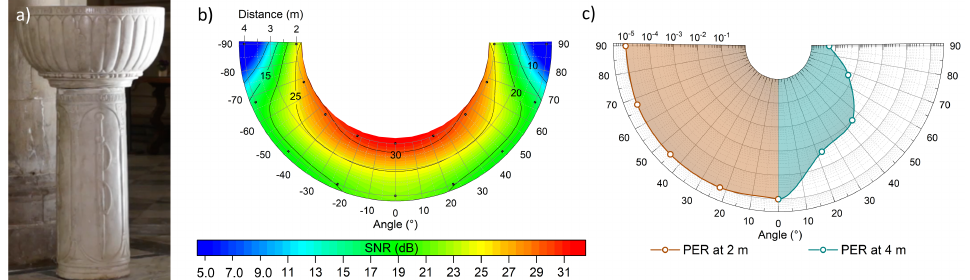
Figure 5. ( a ) Bordoni’s Holy Water Font ; ( b ) polar map of the received SNR amplitude value consider- ing a noise of σ RMS = 2 . 2mV . A 10 dB SNR is still guaranteed at 4 m and with 75° misalignment. Black dots represent the experimental data, whereas the colour map is a cubic spline interpolation. ( c ) Communication performances in terms of PER at 2 m (orange area) and 4 m (green area) as a function of the radial angle. At 2 m, an error-free communication has been performed for all the angles, while at 4 m a PER < 10 − 1 is always